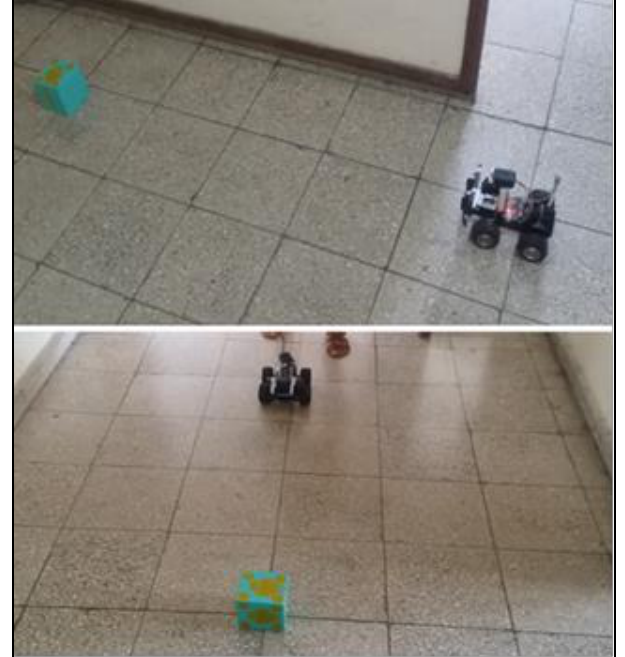
Figura 10: Robot realizando la detección del objeto. Fuente: Los autores,